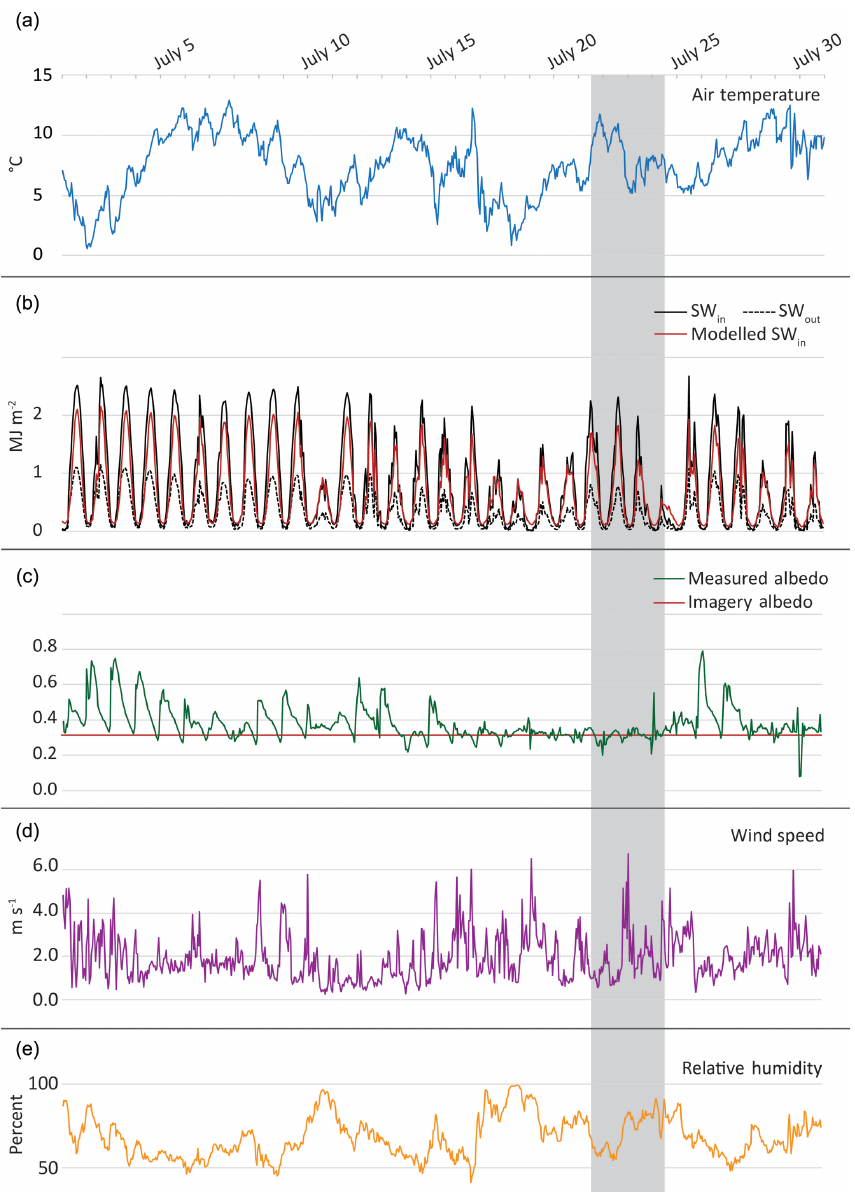
Figure 2. Hourly averaged melt model input variables, measured at the AWS for the period 1–31 July 2016. Variables include near-surface air temperature (a) , incoming (SW in ) and outgoing (SW out ) shortwave radiation (b) , albedo (c) , wind speed (d) , and relative humidity (e) . Inputs which are estimated for distributed models are shown in red for incoming shortwave radiation (a) and albedo (b) . The albedo derived from UAV imagery is scaled using the average value at the AWS for 21–24 July so that it remains constant throughout the model. The dates of the UAV study are shown in